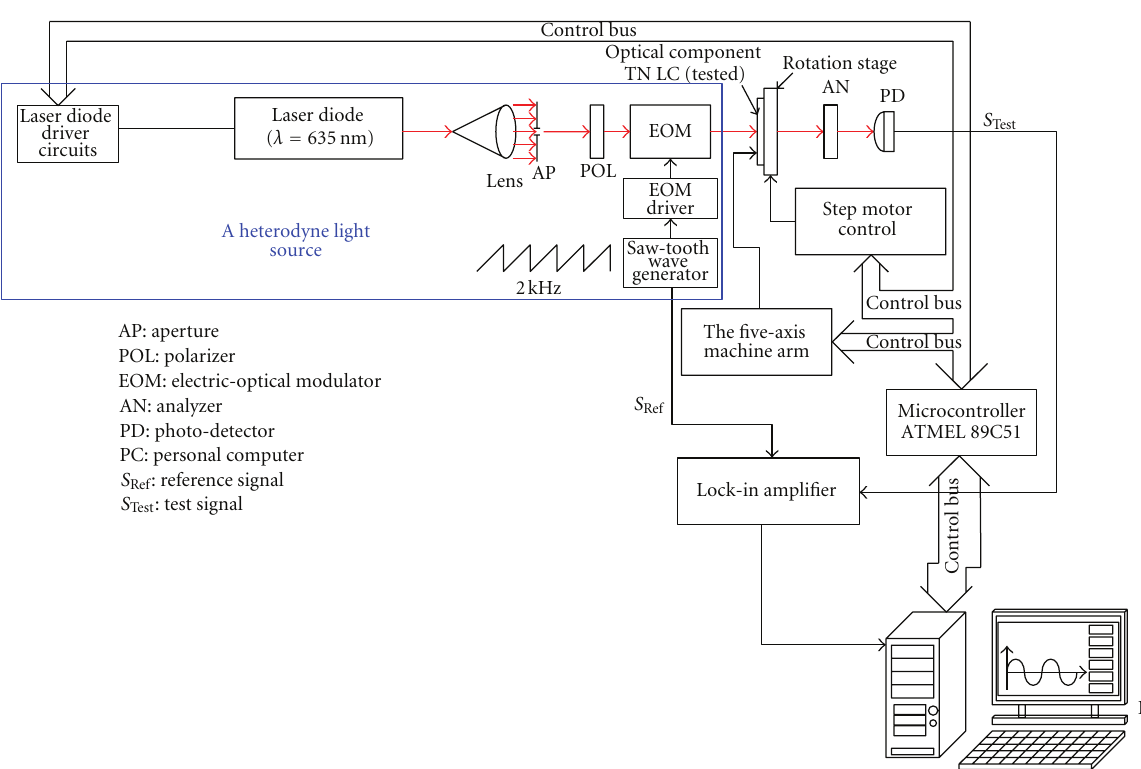
Figure 5: The experimental setup of the self-made automobile heterodyne interferometer.